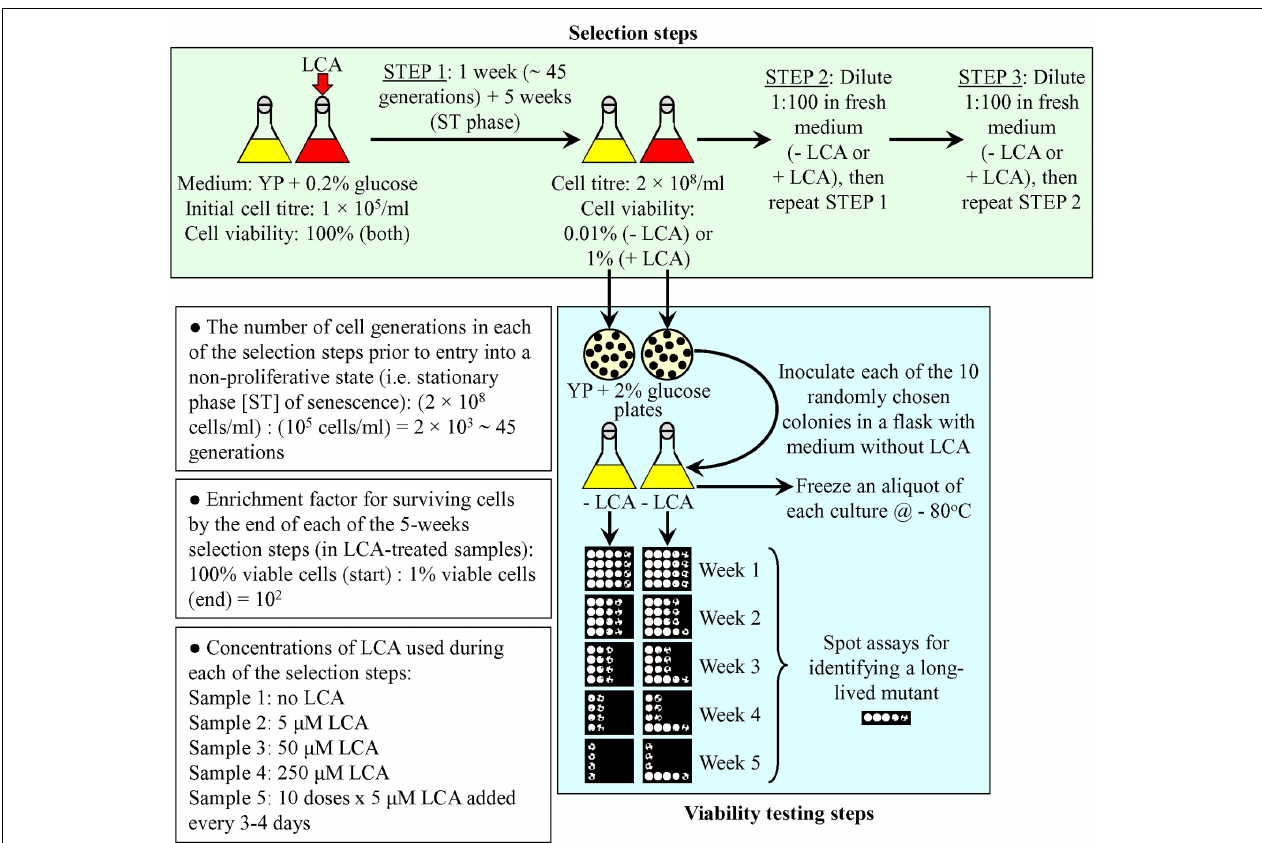
FIGURE 1 | A three-step process for selection of long-lived yeast species by a lasting exposure to LCA under laboratory conditions. For each of the 5 weeks-long selection steps, the number of cell generations and enrichment factor for surviving cells were calculated as shown. The genomes of some of the cells surviving a selection step may contain mutations that extend yeast chronological lifespan (CLS). The genomes of other cells surviving a selection step may not undergo any changes affecting their CLS; the survival of these cells may have been caused only by the ability of LCA to extend yeast CLS. LCA concentrations used during each selection step are indicated. See text for details. LCA, lithocholic acid; ST, stationary growth phase; YP, medium containing 1% yeast extract and 2%